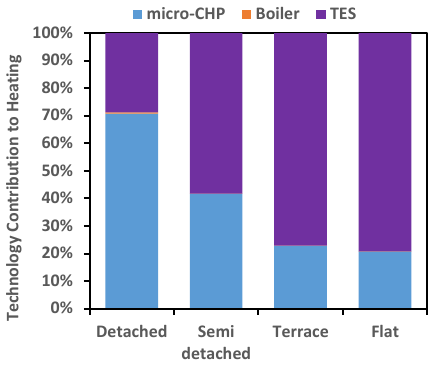
Figure 7. Incentivised design (FIT) with TES.